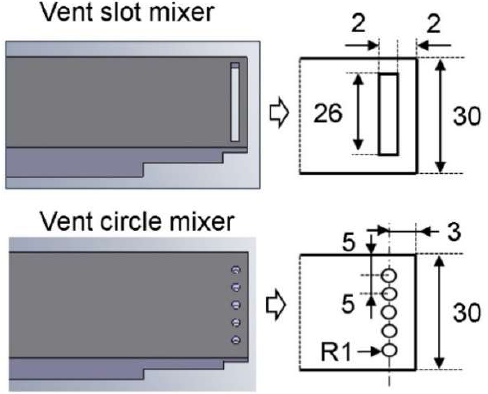
Figure 2. Mixer models: vent slot mixer and vent circle mixer.